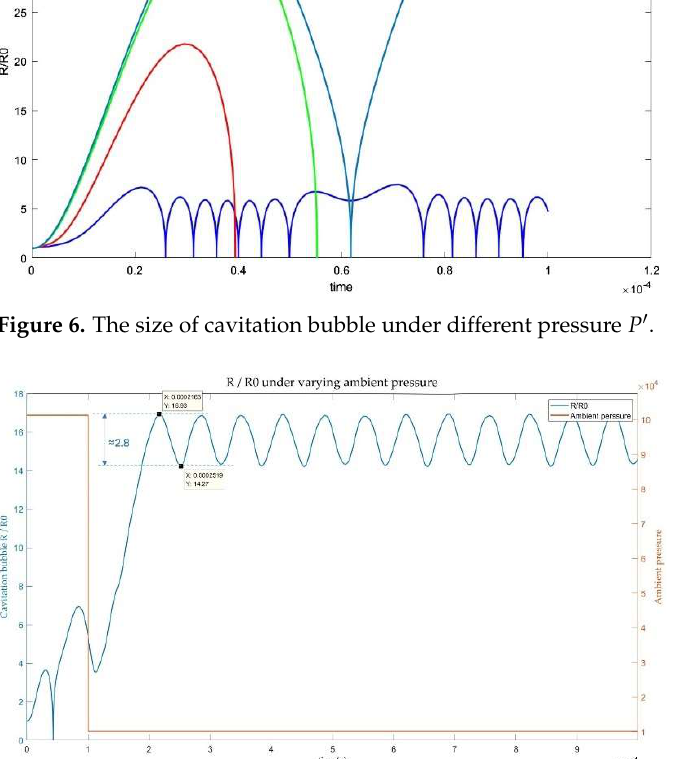
Figure 6. The size of cavitation bubble under different pressure 𝑃 (cid:4593)